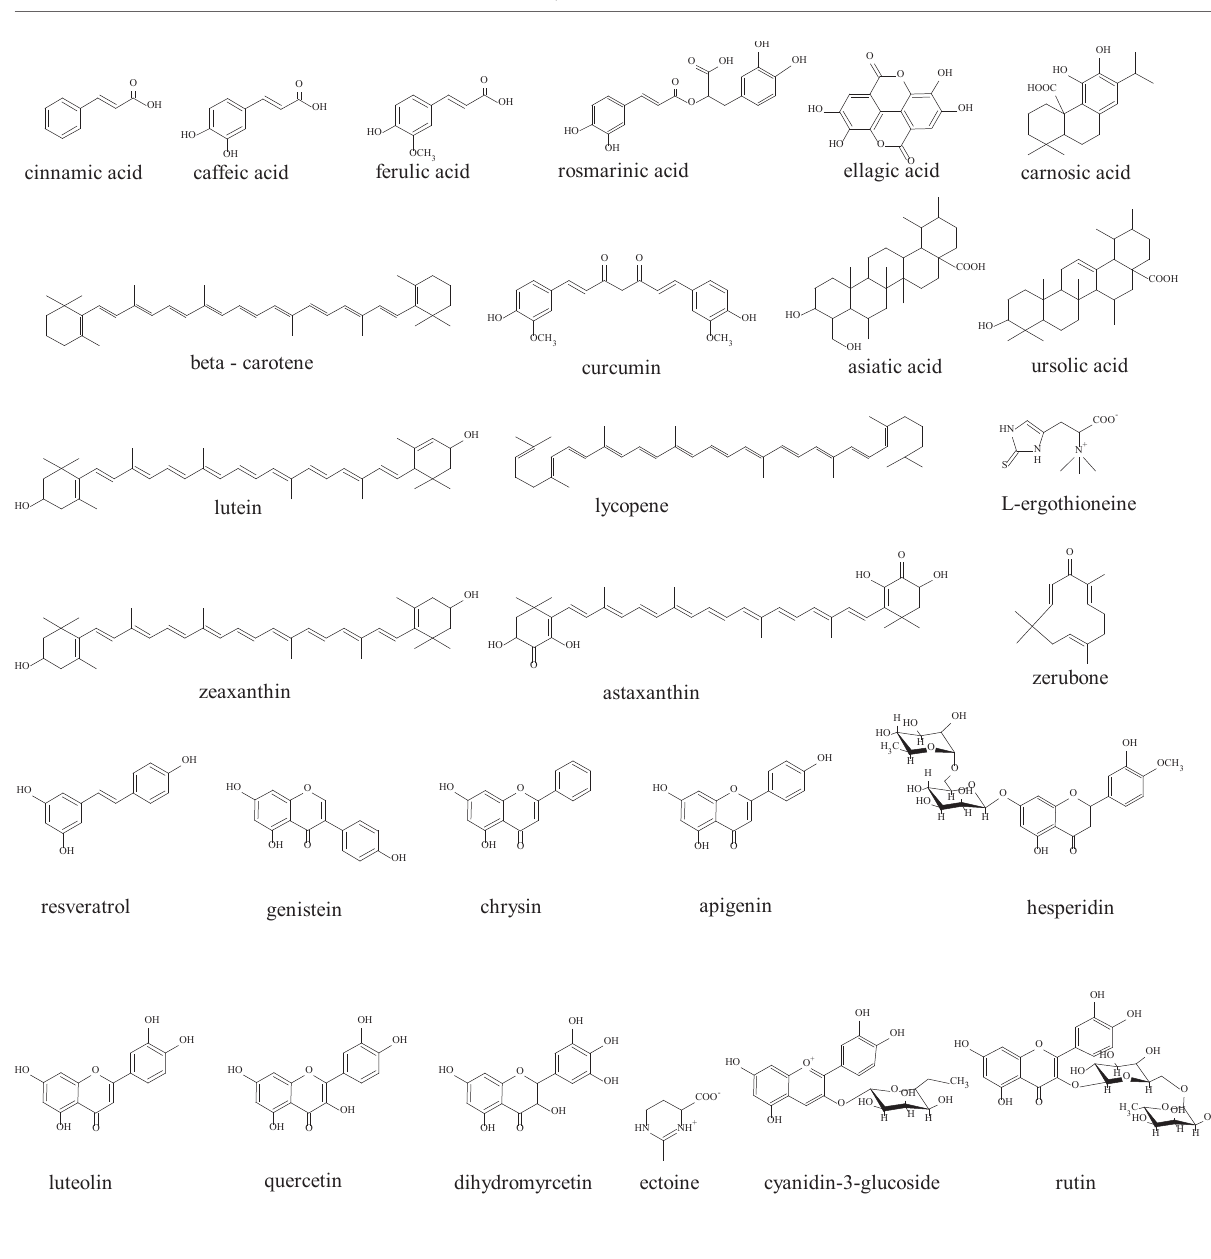
Fig. 2. Structures of phytochemicals with UVA protective